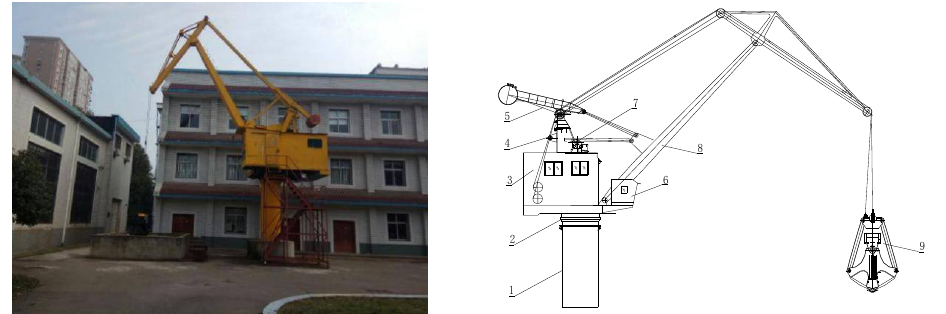
Figure 10. Physical diagram of grab dredger: 1—support cylinder; 2—turntable; 3—machine room; 4—load sensor; 5—balance system; 6—driver’s cab; 7—luffing mechanism; 8—boom system; 9— grab.